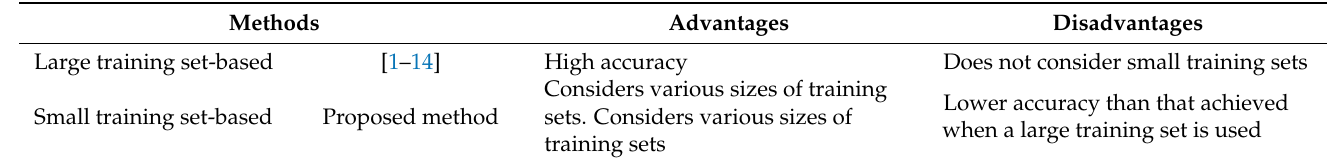
Table 1. Comparison between the proposed and previous methods for plant image classification.